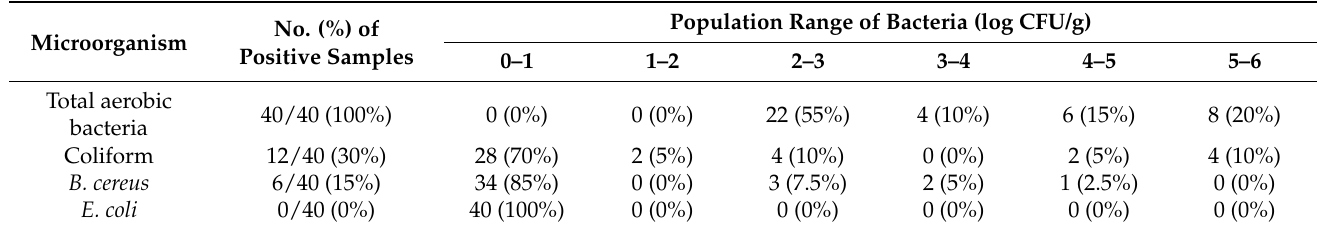
Table 2. Microbial counts of total aerobic bacteria, coliform, B. cereus , and E. coli in chilled tofu.